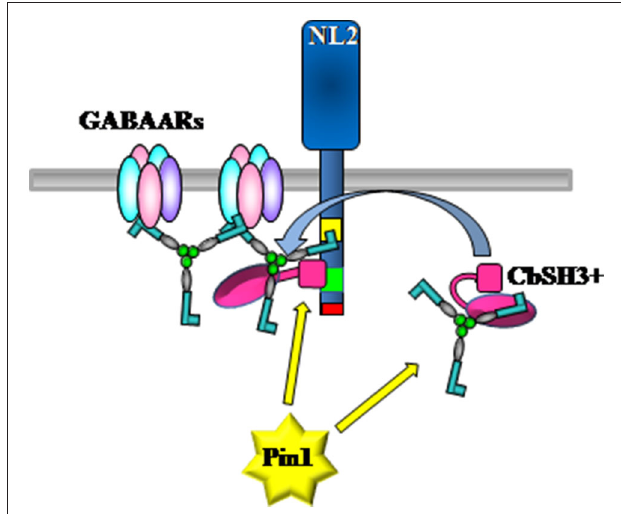
FIGURE 3 | Model of collybistin-driven recruitment of gephyrin by NL2 at GABAergic postsynapses . Pin1 may affect gephyrin/collybistin as well as gephyrin/NL2 interactions leading to an increase or decrease in gephyrin deposition at post-synaptic sites. The cytoplasmic domain of NL2 contains a gephyrin binding domain (yellow), a putative CBD (green) and a C-terminal PDZ binding domain